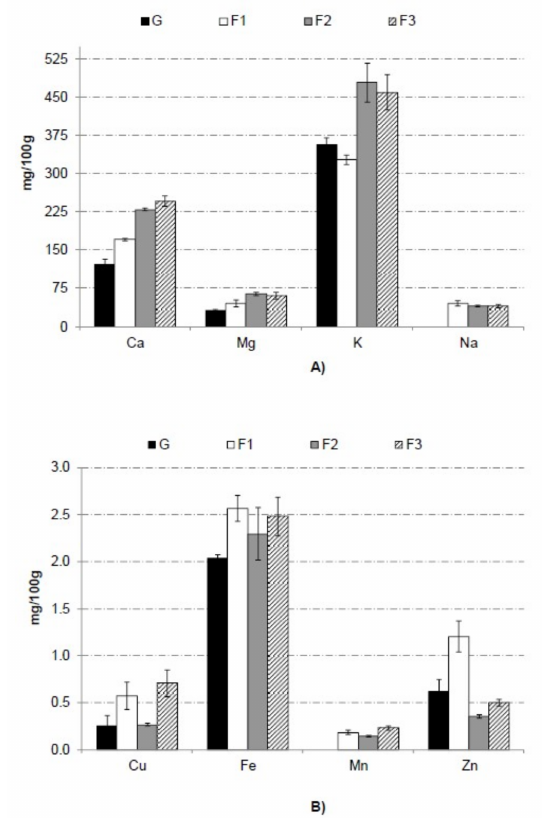
Figure 3. Macrominerals ( A ) and microminerals ( B ) content of grapefruit powder (G) and each formulation (F1, F2, and F3). Letters indicate homogeneous groups established by the ANOVA ( p < 0.05) for each